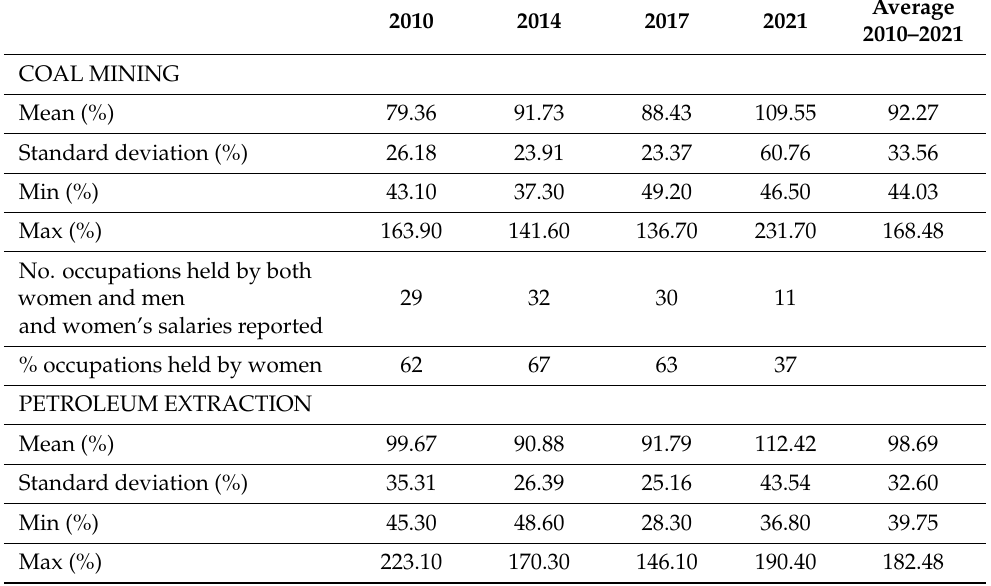
Table 4. Descriptive statistics of gender pay gap within